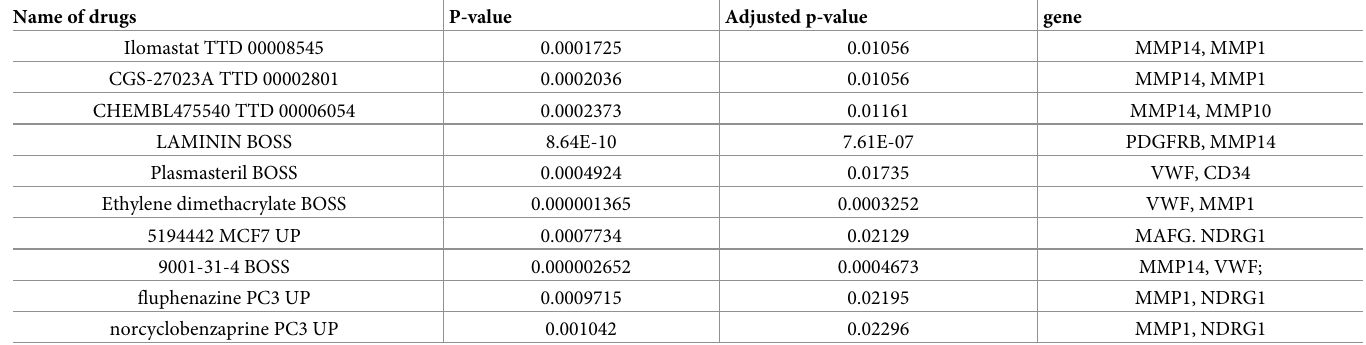
Table 5. List of the suggested drugs for UP-DEGs of HCC with COVID-19.